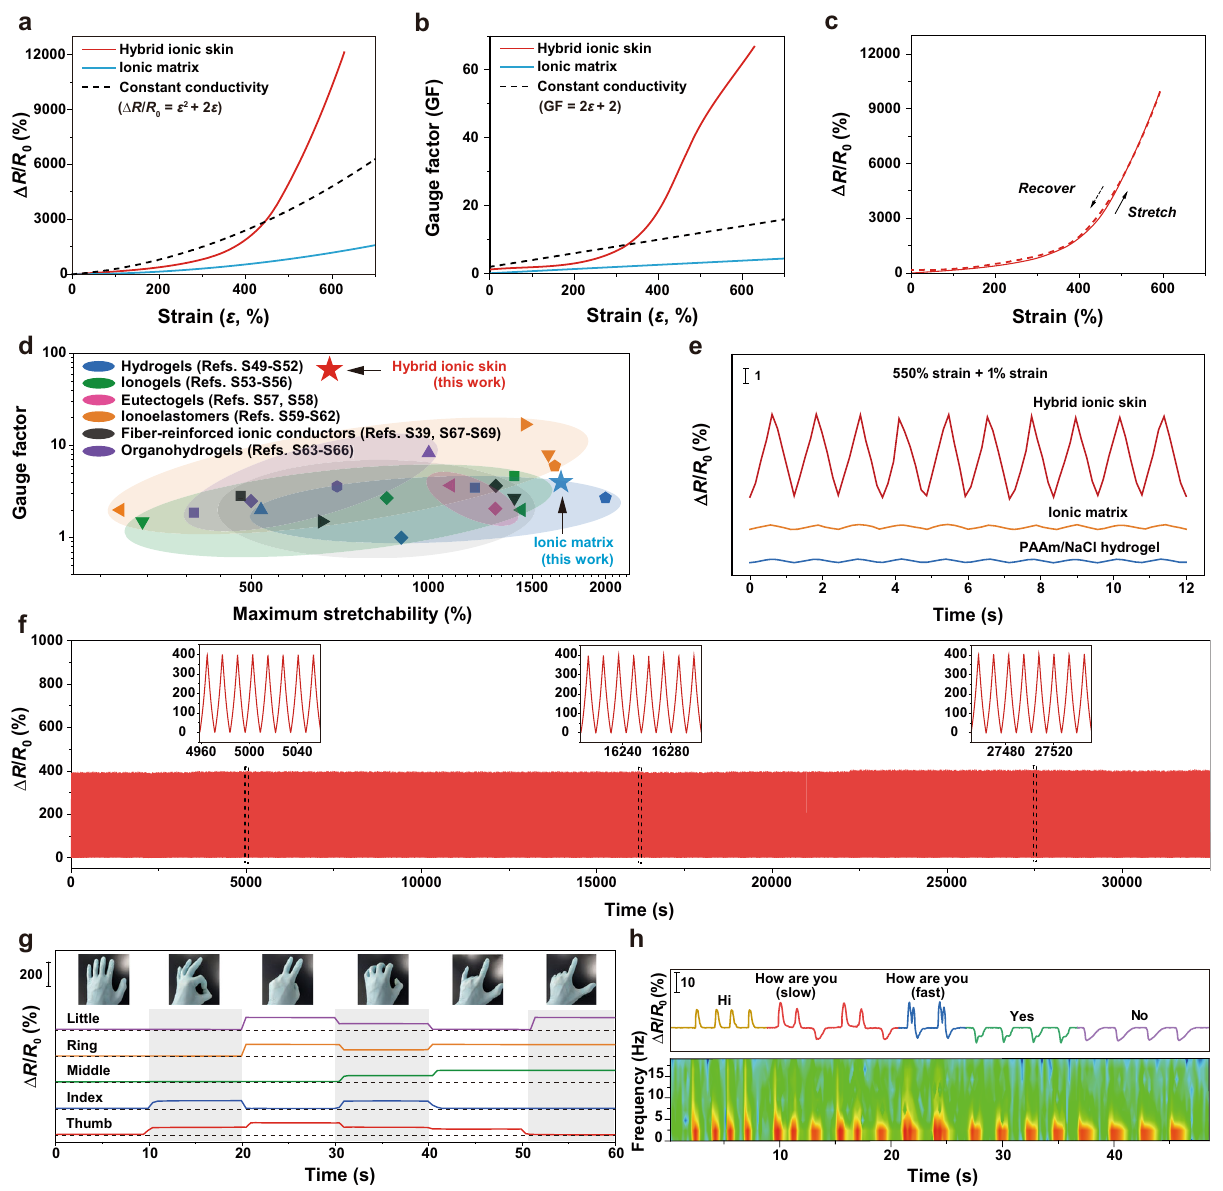
Fig. 4 | Enhanced strain sensation of hybrid ionic skin. a Strain-dependent resistance changes of hybrid ionic skin, ionic matrix, and conductivity-constant conductors. b Corresponding gauge factor (GF) changes. c Reversible resistance changesofhybridionicskinasstretchedandrecovered. d ComparisonofGFvalues and maximum stretchability among hybrid ionic skin and other intrinsically stretchable ionic conductors. e Comparison of resistance changes among hybrid